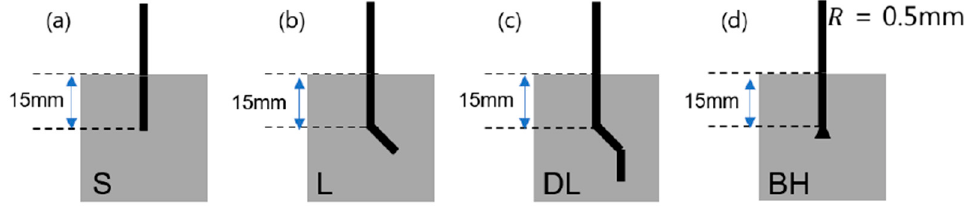
Figure 2. Shapes of Ni/Ti SMA wires employed in the pullout resistance characterization: ( a ) Straight SMA fibers (S-type); ( b ) L-shaped SMA fibers (L-type); ( c ) double-L shaped SMA fibers (DL-type); and ( d ) bulged-headed SMA fibers (BH-type).